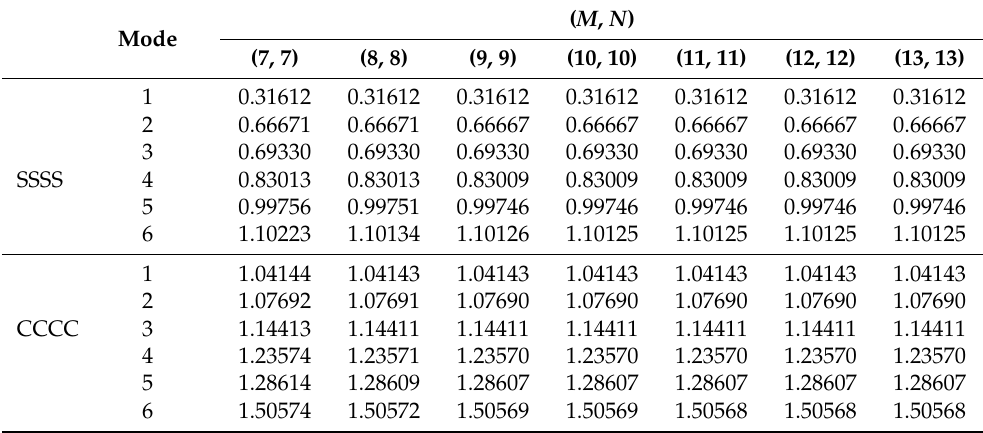
Table 3. Convergence of the first six dimensionless natural frequencies of the GPLRP, two-cylindrical- panel system (Porosity-I, GPL A, e 1 =